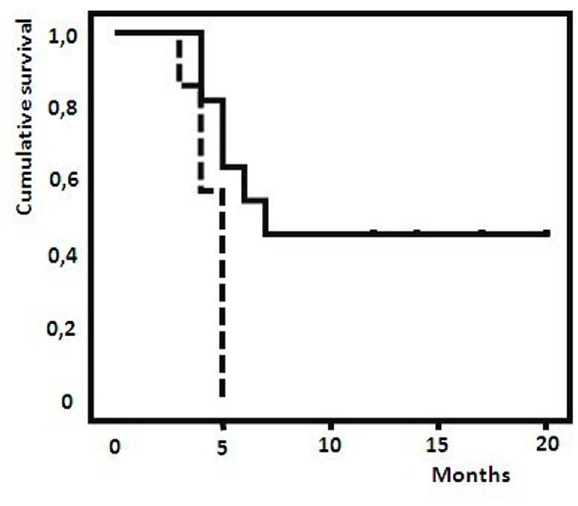
Figure 3. Kaplan-Meyer analysis which considered contemporary up-regulation of all 4 peaks (m/z 5900, 12544, 49124, 11724) with respect to progression free survival in patients treated with vemurafenib. p 5 0.011. — : patients with basal level of the 4 peaks; ---: patients with overexpression of all 4 peaks.